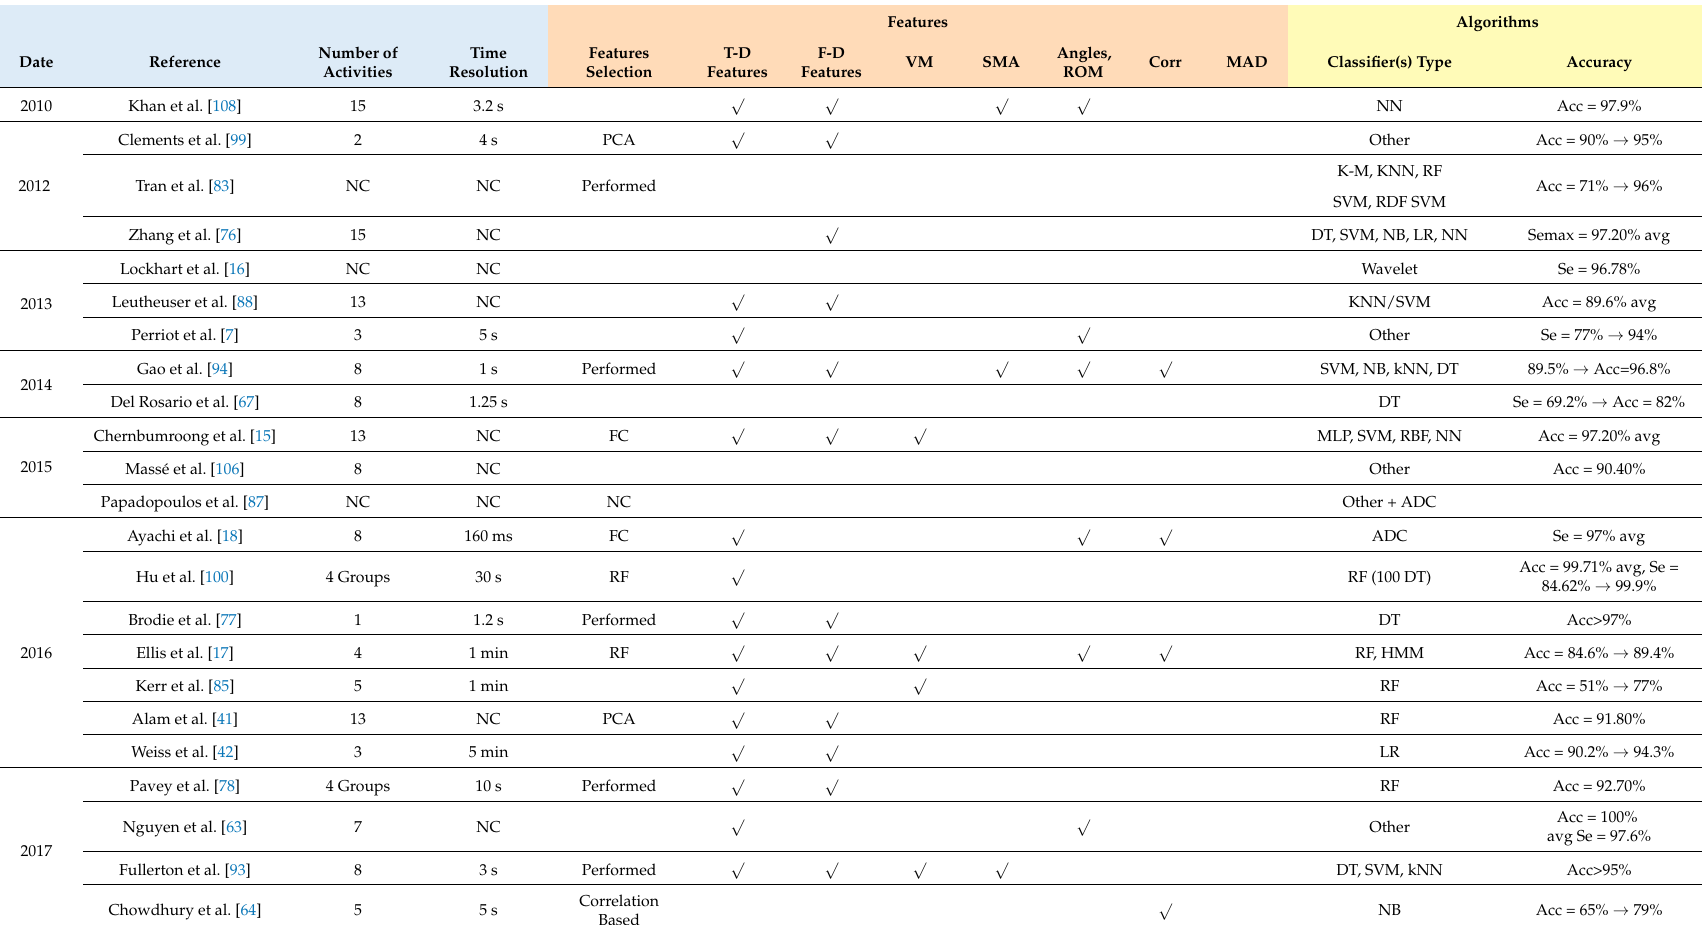
Table 4. Summary of all the specificities of the studies selected for this review which classify performed activities. The features retained as well as the nature of the classifiers and their precision are detailed (acc: accuracy, se: